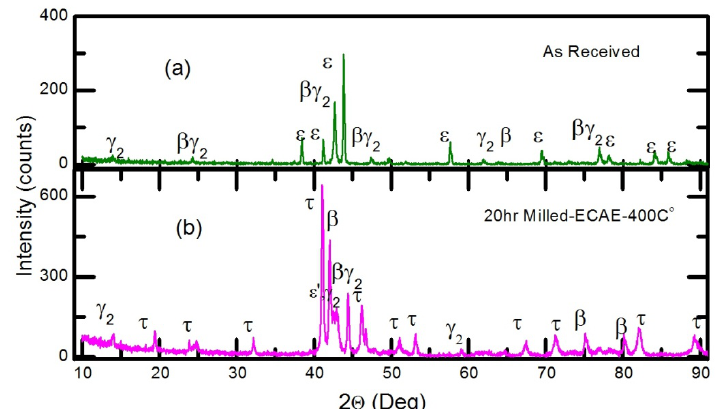
Figure 1. X-ray diffraction patterns of as-received gas-atomized powder ( a ) and after ECAE of milled powders at 400 °C for 30 min ( b ).